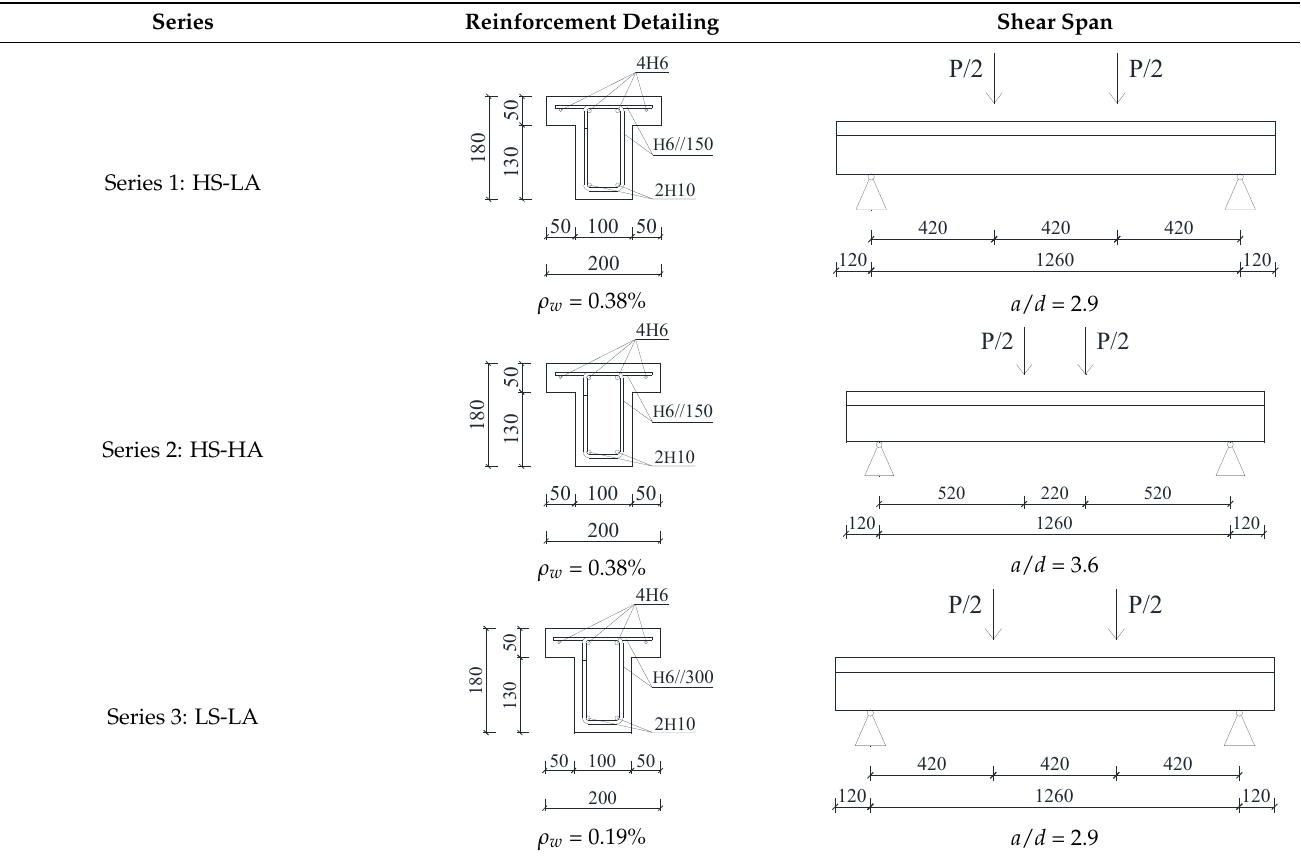
Table 1. Reinforcement detailing and loading arrangement for the three test series (in mm).